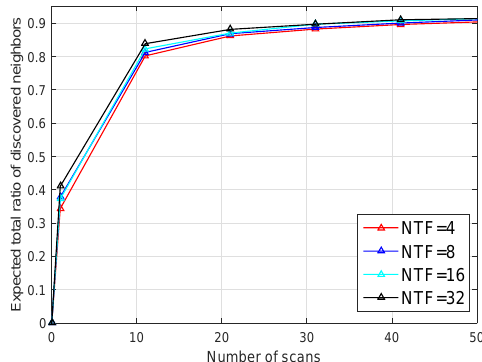
Figure 13. Performance of different number of time-frequency resource blocks.